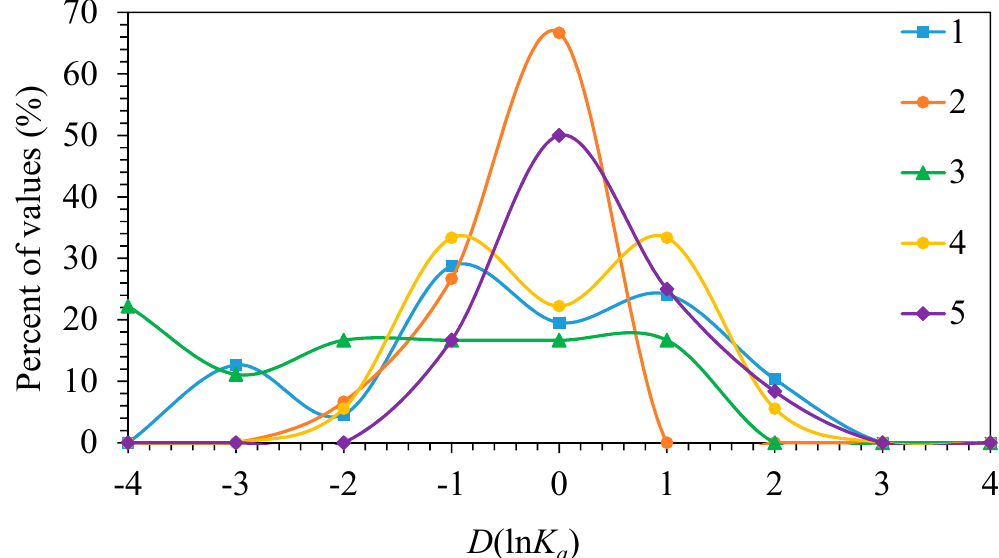
Figure 9. Distributions of the number of values of the binding constants binned by their deviation D ( ln K a ) from the median binding constant for the given ligand and albumin type. A separate distribution is plotted for each of the five different literature sources (1–5).